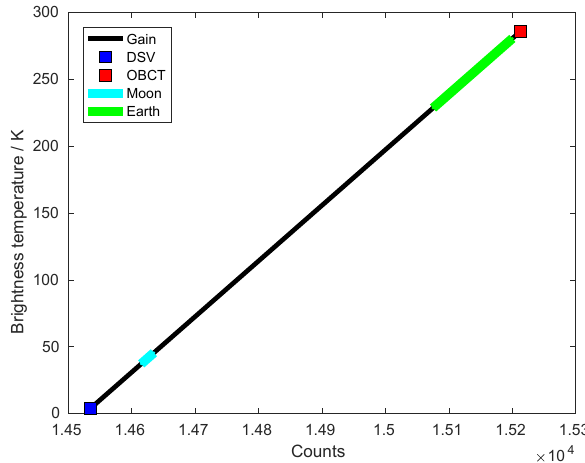
Figure 3. Schematic representation of the signal range in counts and brightness temperature covered by deep space, Moon scenes, Earth scenes, and internal calibration target for channel 20 of AMSU-B on NOAA-16 in October 2008. A gain of 2.4countsK − 1 was assumed. The Moon gives a much lower signal than the Earth, because it fills only a fraction of the